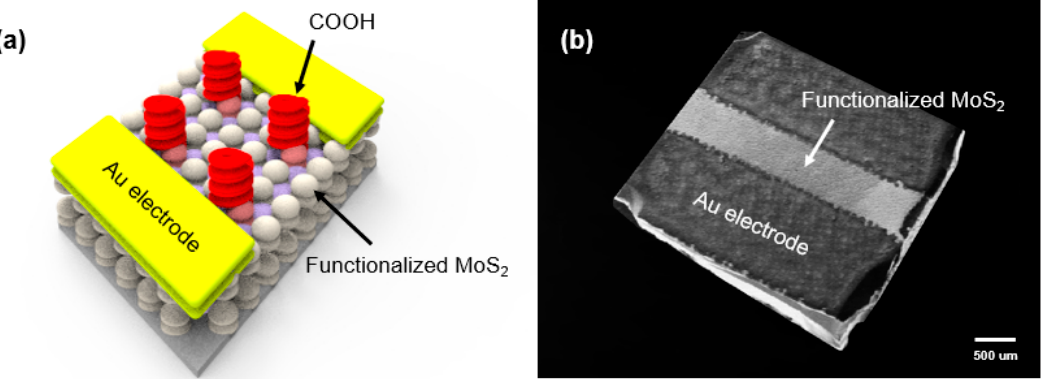
Figure 1. ( a ) Schematic representation and ( b ) SEM image of the gas sensor prepared with an MoS 2 film functionalized by plasma treatment for 2 s at 10 W and exposure to an 3-Mercaptopropionic acid (MPA) solution overnight.